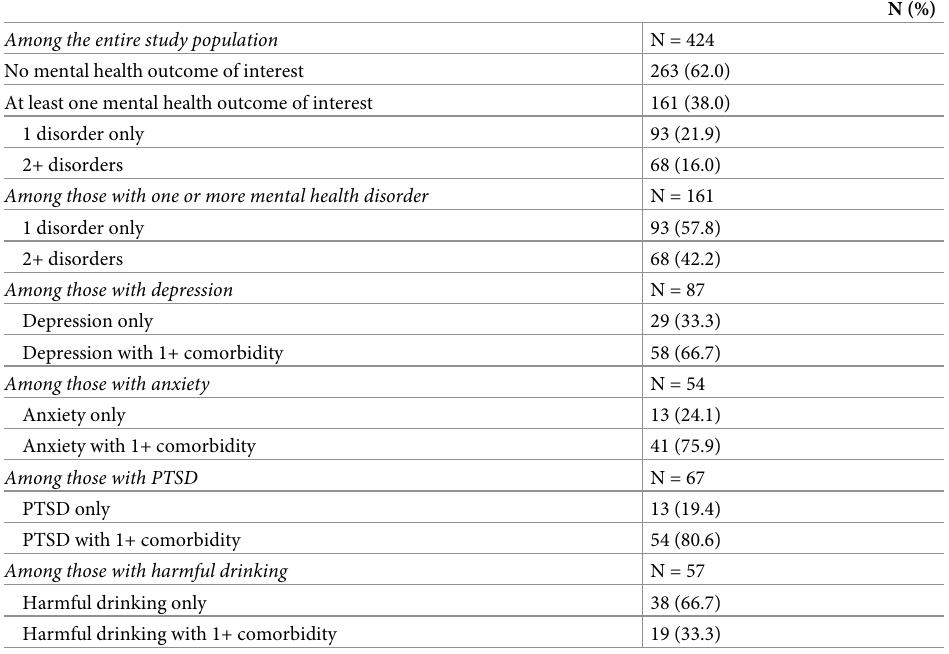
Table 2. Mental health and substance use disorder symptoms of 424 individuals initiating HIV care in Cameroon.